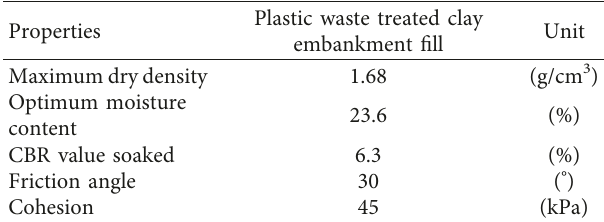
Figure 2: Modeled geometry of an embankment on PLAXIS 2D. Table 1: The physical properties of plastic waste treated clay.